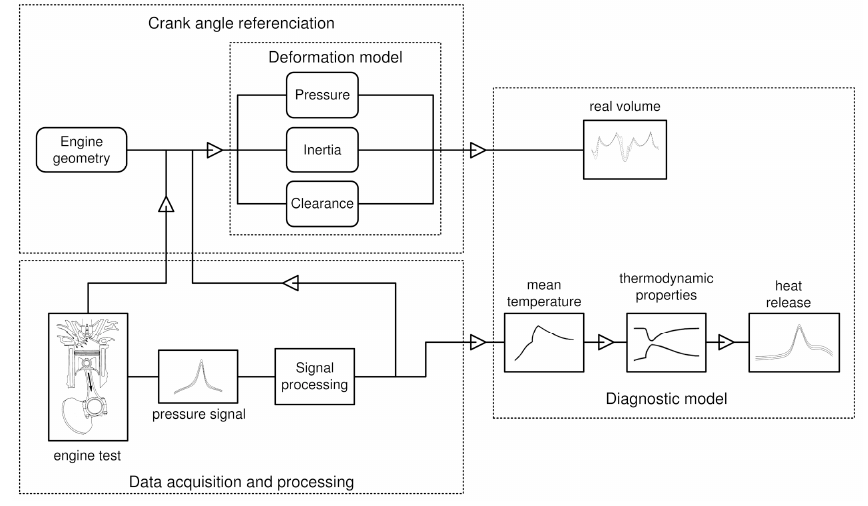
Figure 1. General scheme of the diagnostic model.